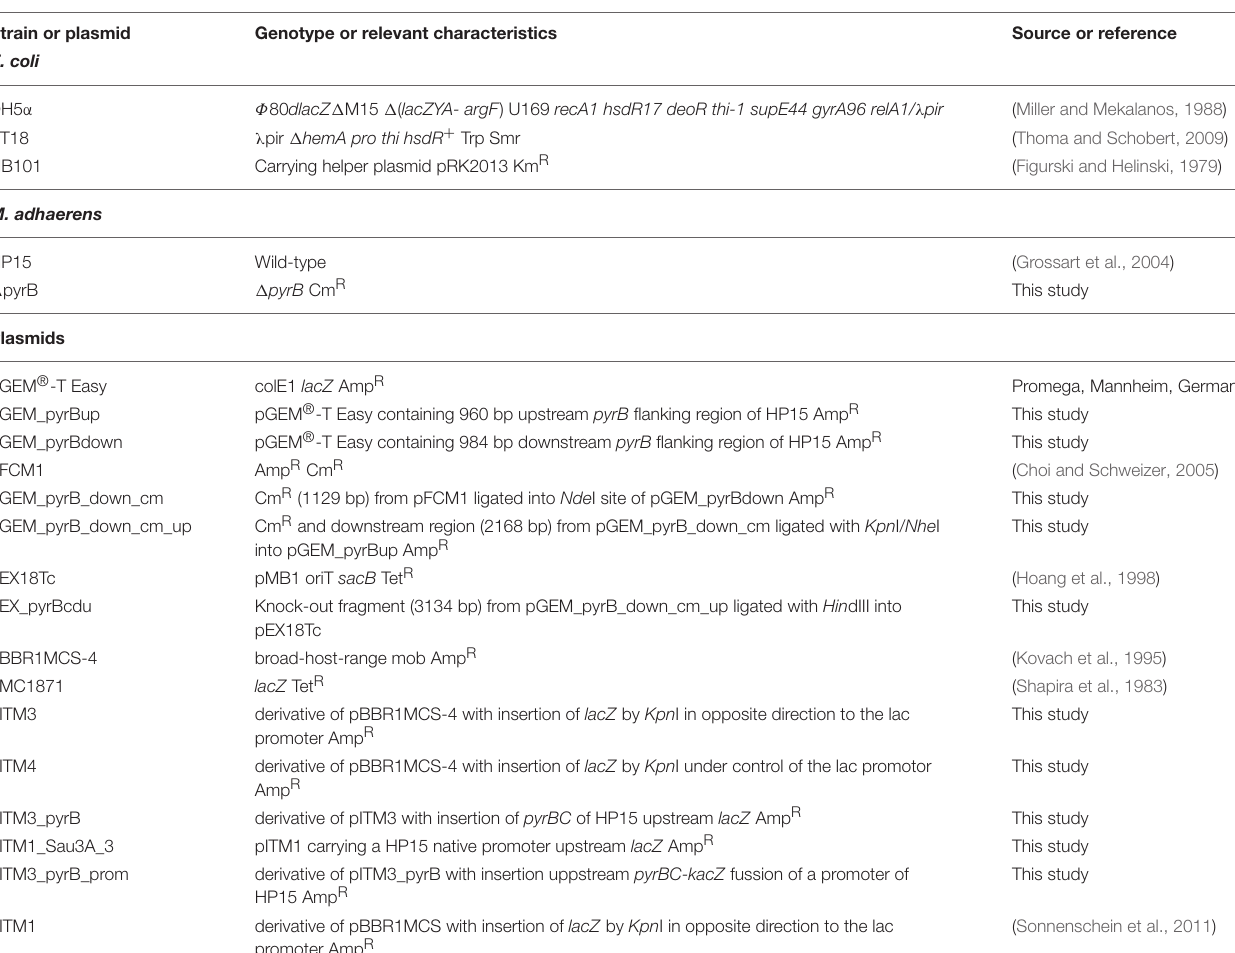
TABLE 1 | Strains and plasmids used in this